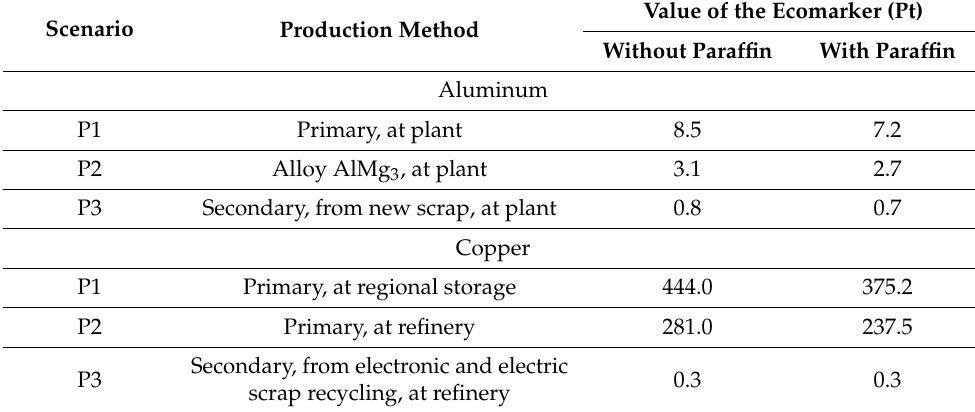
Table 2. Values of Pt for the ETC with and without paraffin, depending on the production method; the values of Pt from SimaPro software.